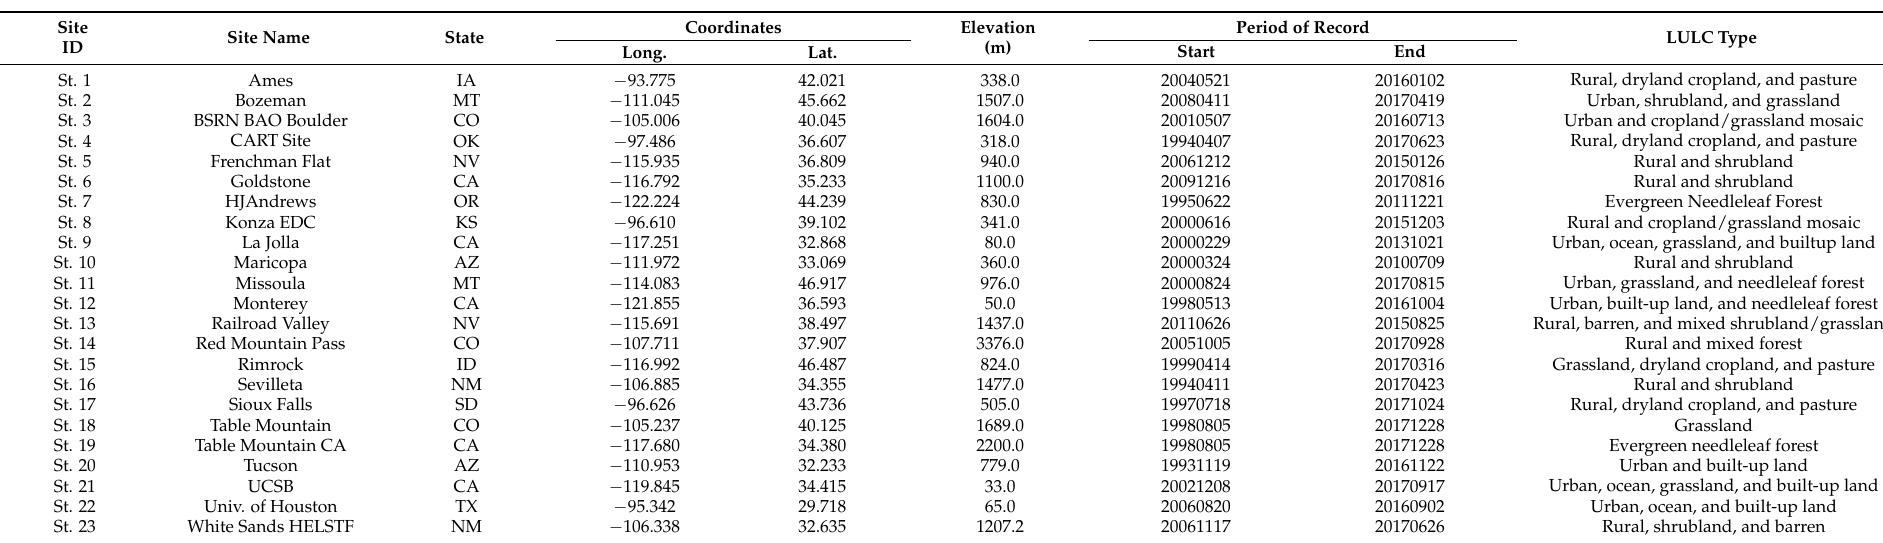
Table 1. Geographic information, time range of available data at AERONET sites [45], and land cover/land use type (https://nationalmap.gov/small_scale/mld/landcvi.html (accessed on 1 October 2019) for 23